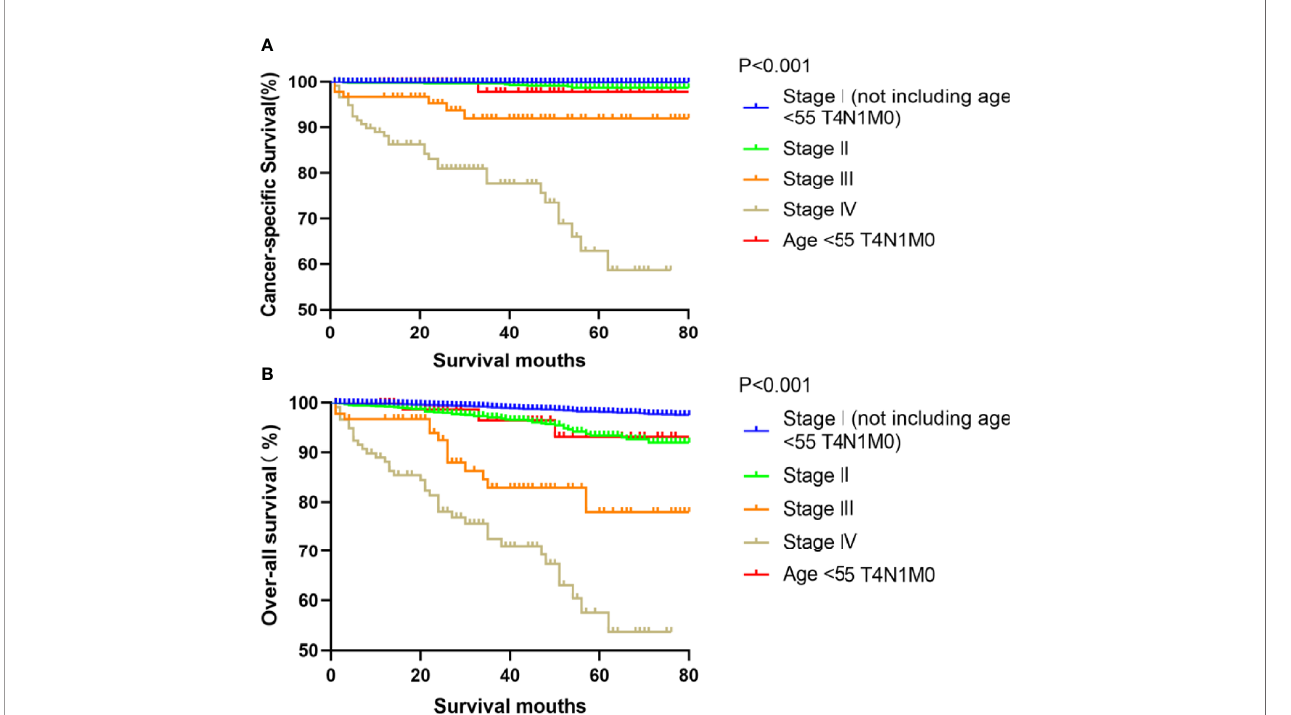
FIGURE 1 | Kaplan – Meier curves for cancer-speci fi c survival (A) and overall survival (B) between FVPTC patients in stage I (not including age <55 T4N1M0), II, III, IV and those aged <55 years with stage T4N1M0 disease.